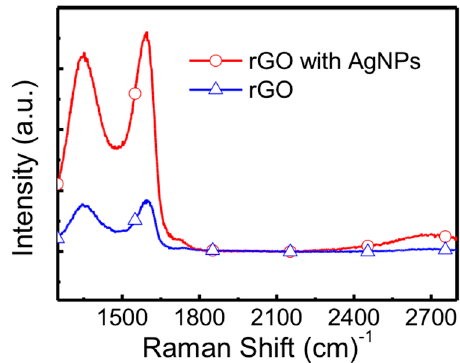
Figure 2. Raman spectra of rGO and Ag nanoparticles-rGO hybrid films. The Raman intensity of rGO with Ag nanoparticles is enhanced owing to the surface plasmon resonance effect.